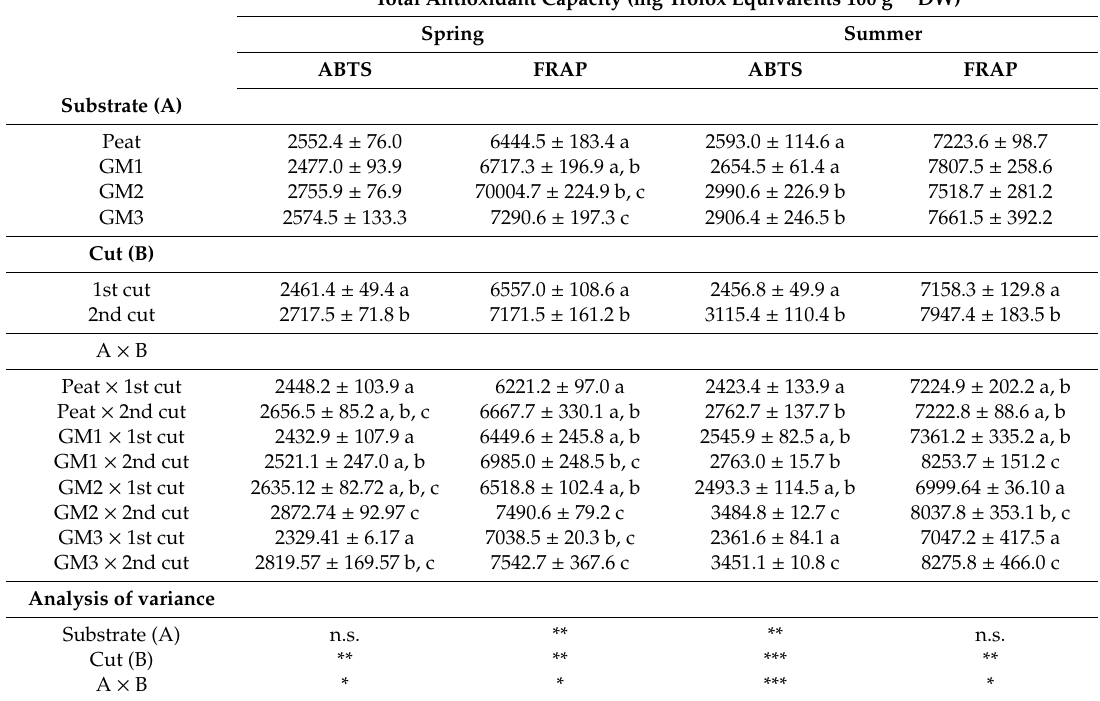
Table 6. Total antioxidant capacity (FRAP and ABTS methods) in leaves of baby leaf red lettuce grown on di ff erent substrates (peat, GM1, GM2, GM3) and harvested twice (1st and 2nd cut), cultivated in spring and summer cycles in a floating